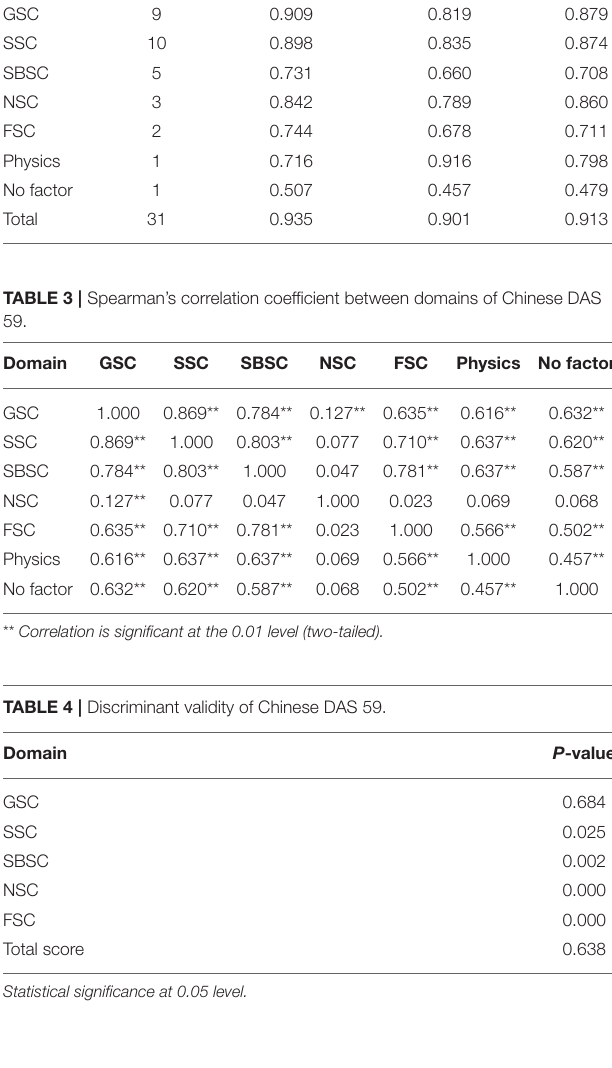
TABLE 2 | Reliability and internal consistency of Chinese DAS 59 using Guttman’s split-half coefficient. Domain